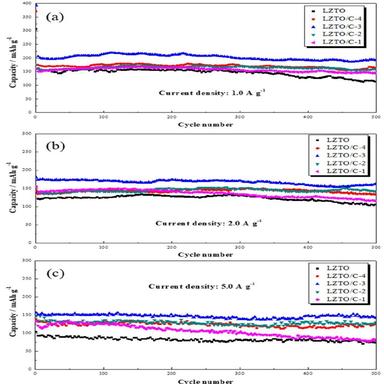
Cycling stabilities and specific discharge capacity of non-carbon coated LZTO and N-doped carbon coated LZTO over 0.05–3.0 V (versus Li+/Li) at 1.0, 2.0, and 5.0 A g−1 , respectively.